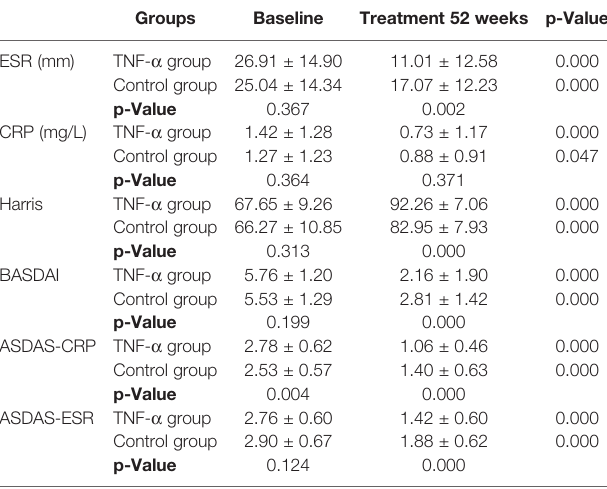
TABLE 3 | Clinical outcomes and hip function from baseline to 52 weeks between the TNF- a inhibitor group and control group. Groups Baseline Treatment 52 weeks p-Value